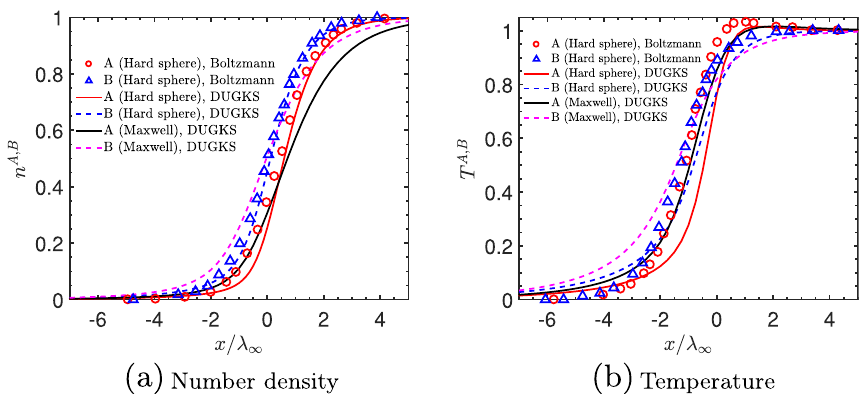
Fig. 10 Shock structure of different molecular models with Ma − = 3.0 , m B ∕ m A = 0.5 , and 𝜒 A = 0.1